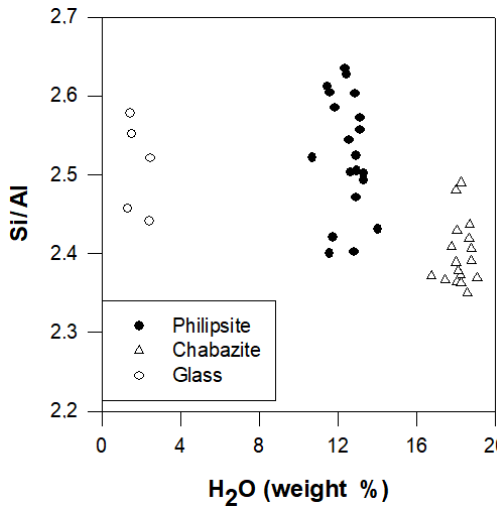
Figure 10. Si / Al ratio (calculated on the basis of half of Barth’s an- hydrous standard cell content) in zeolites and glasses of TRS versus (cid:113) (cid:113) water content Figure 9. Log a K + 2 / Ca ++ vs. log a Na + 2 / Ca ++ diagrams for zeolites of TRS at 120, 150, and 200 ◦ . Log a SiO 2 = − 3 . 7; log a H 2 O = 1.